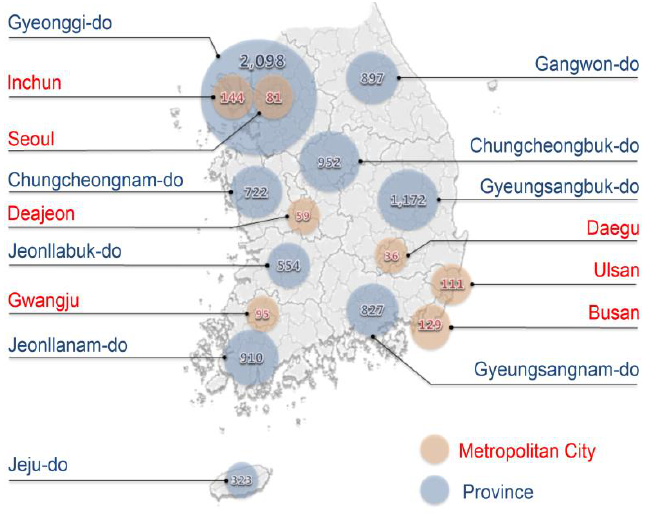
Figure 4. DIA results of metropolitan cities and provinces (2015 – 2017).